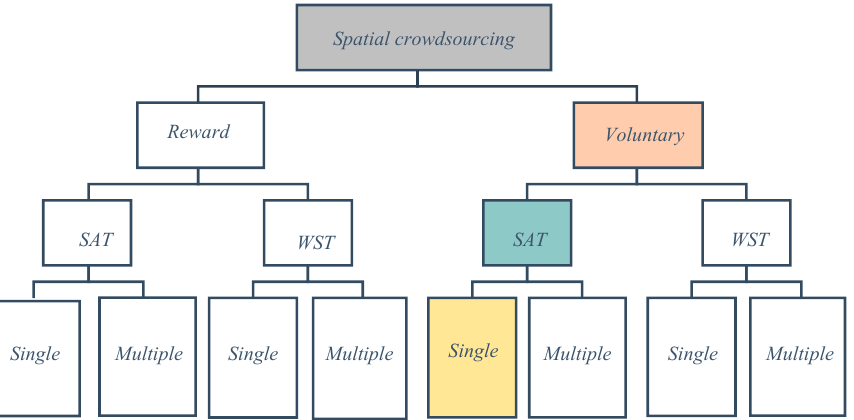
Figure 1. A classification of spatial crowdsourcing. Reward = reward-based worker; voluntary = voluntary-based worker; SAT = server-assigned task; WST = worker-selected task; single = single worker; multiple = multiple workers.